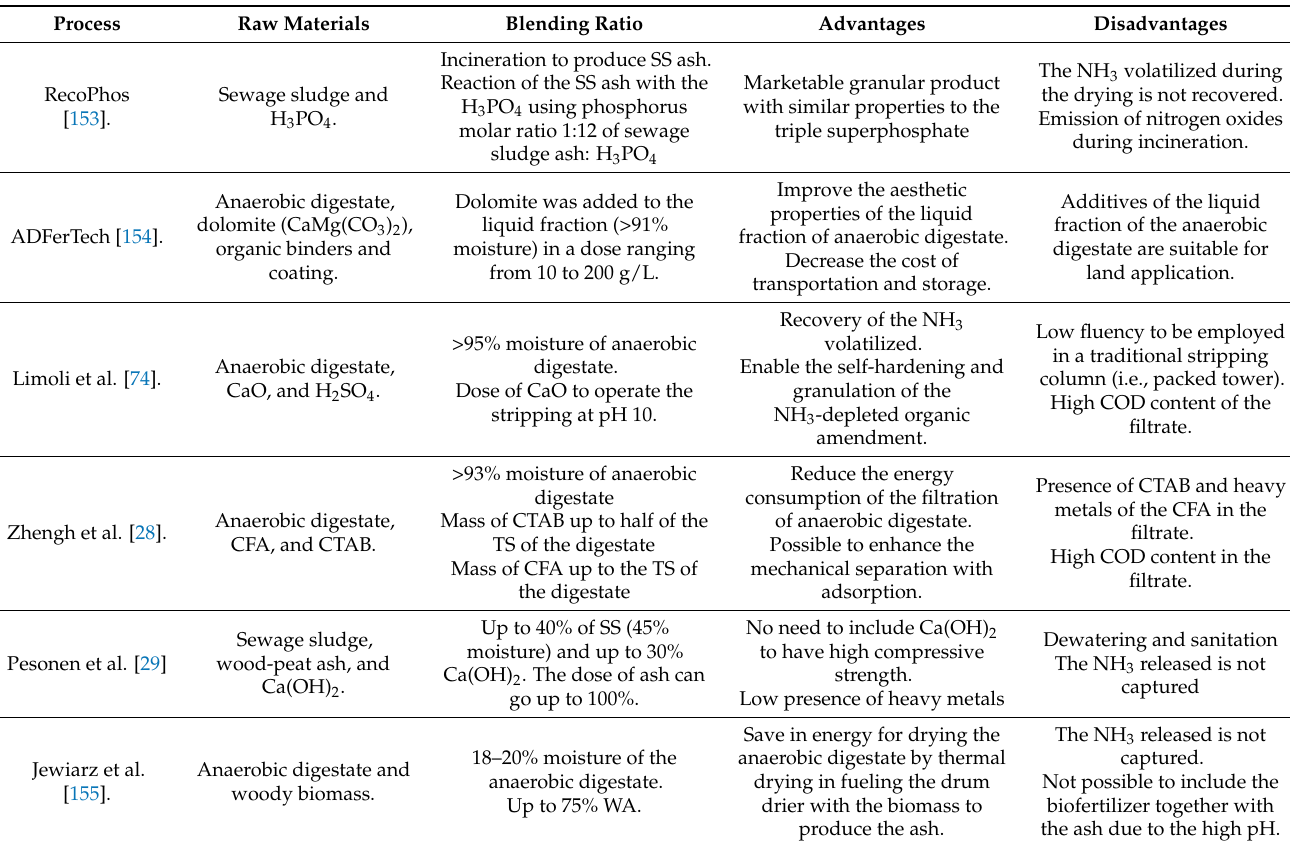
Table 4. Identification of the synergies and possibilities in the process involving the mixture of anaerobic digestate or sewage sludge with WA or alike